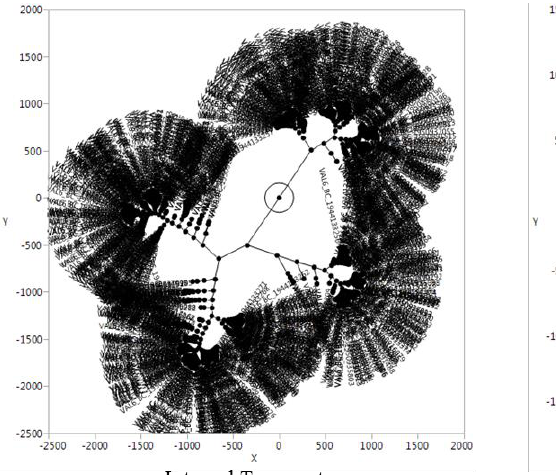
Figure 4. Parallel-coordinate plots from the pattern similarity cluster.